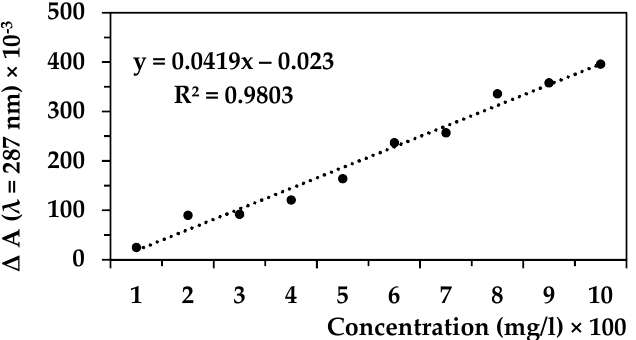
Figure 3. Calibration curve of caffeine in the range 1–10 mg/L (wavelength 287 nm).